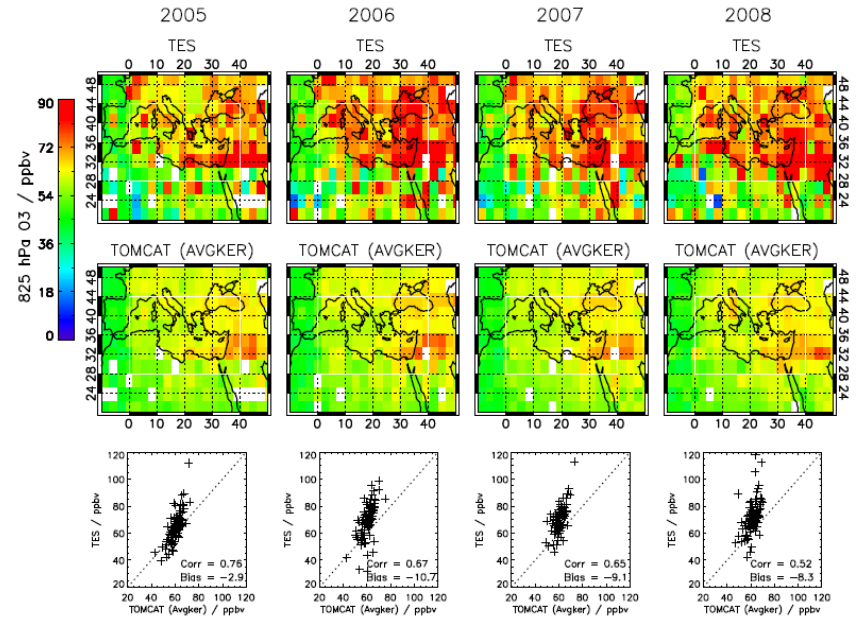
Fig. 2. Comparison of TES (top panels) and TOMCAT (middle panels) 825hPa summertime ozone (ppbv) over the Mediterranean region for the years 2005–2008 inclusive. The TOMCAT model output has been matched in time and space to each TES observation and the TES averaging kernels have been applied before both sets of data have then been averaged over the months of June, July and August. The bottom panels show the correlation between the two datasets within the white box shown in the top two panels.